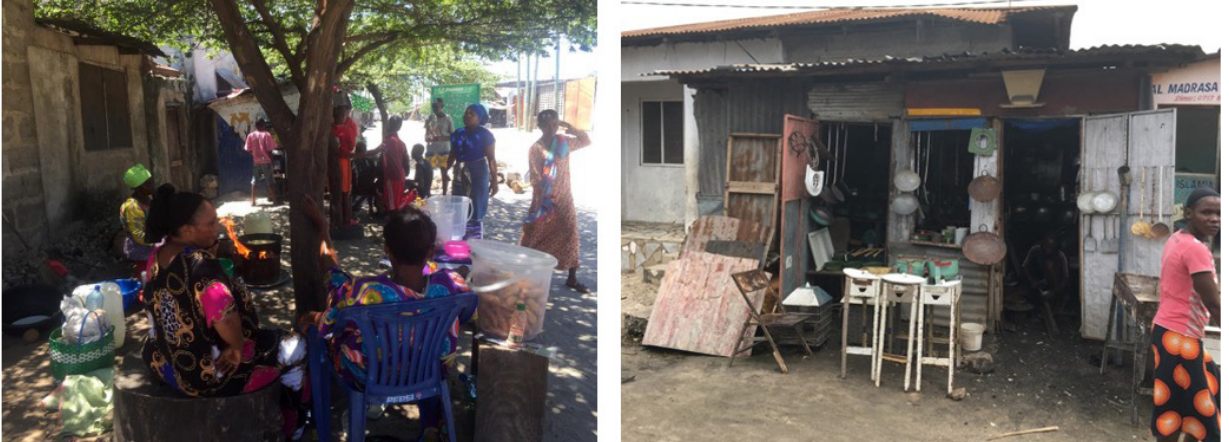
Figure 6. Trees and tree shades generate congregation; front verandas have shifting functions and boundaries. Source: Courtesy of Beatrice Mahagama and Leticia George.